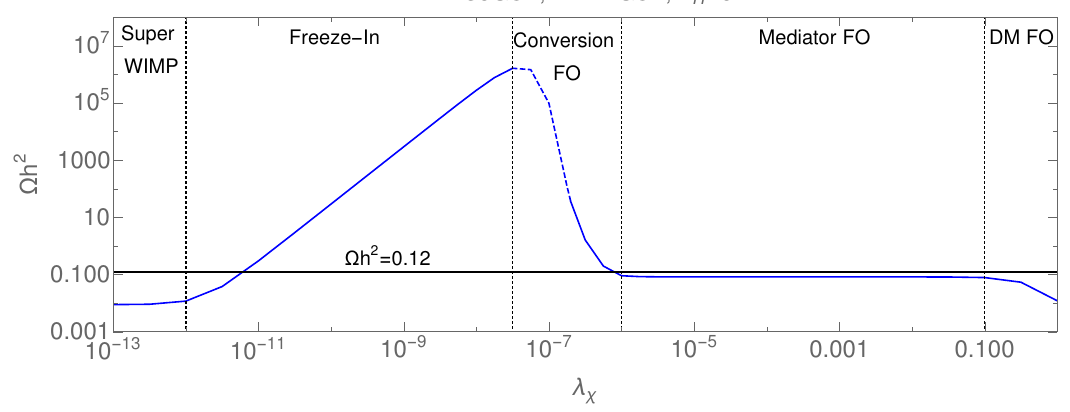
Figure 2 . DM abundance as a function of the Yukawa coupling for m (cid:31) = 150 GeV, (cid:1) m = 2 GeV and (cid:21) H = 0 : 1 (i.e. for compressed DM-mediator mass spectrum). Y is the summed contribution of both the mediator and its antiparticle and we will use (cid:30) x = m =T . 2 The reaction densities have been obtained taking into account all (cid:31)